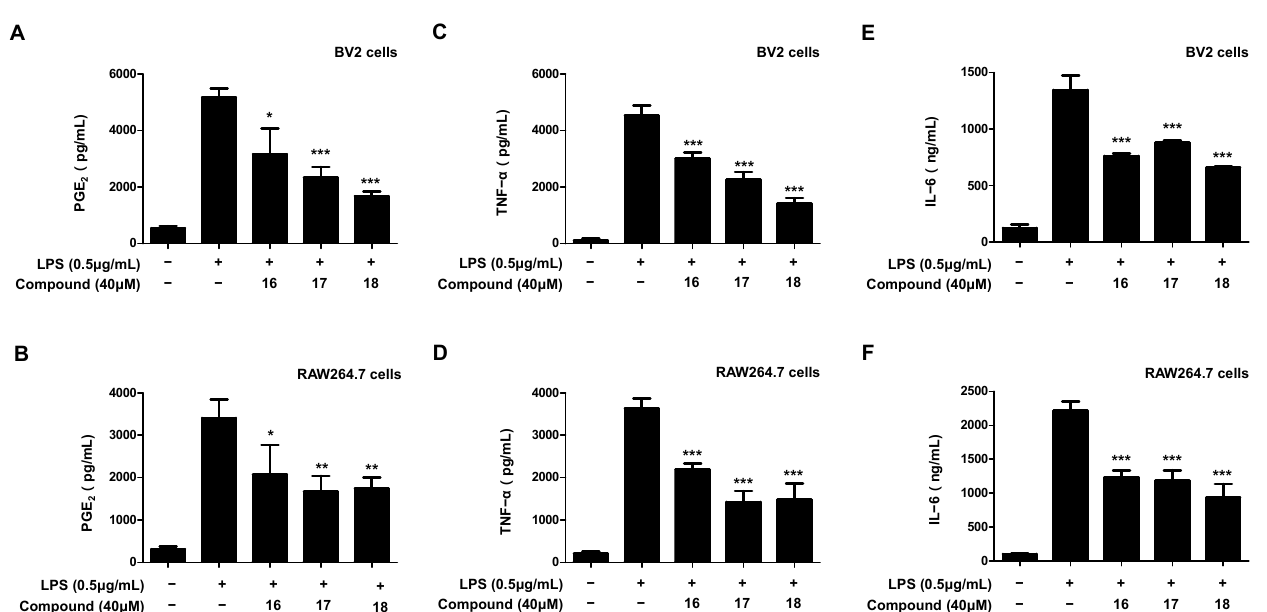
Figure 7. Inhibitory effect of compounds 16 – 18 on the inflammatory mediators PGE 2 , TNF- α , and IL-6 in LPS-induced BV2 microglia ( A , C , E ) and RAW264.7 macrophages ( B , D , F ). The inhibitory effect on PGE 2 , TNF- α , and IL-6 production in BV2 and RAW264.7 cells was induced for 18 h by treatment with LPS after pretreatment with 40 µ M of the compounds. Data are presented as the mean ± standard deviation values of three independent experiments. * p < 0.05, ** p < 0.01, *** p < 0.001 vs. LPS.